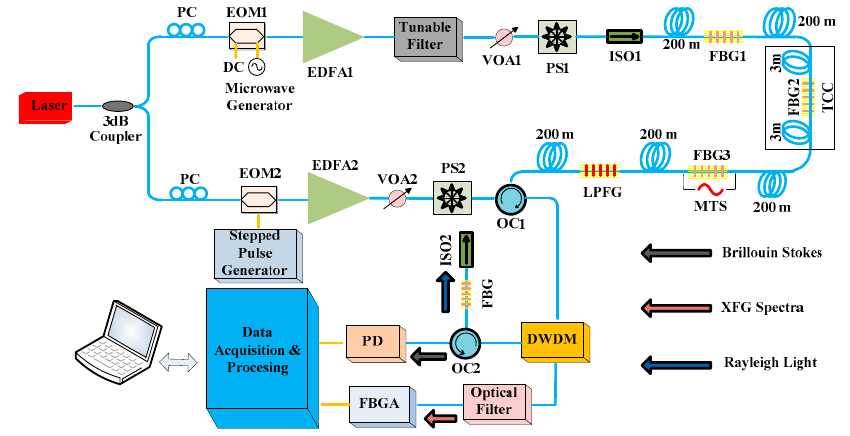
Figure 3. A schematic of the hybrid BOTDA/XFG sensing system.